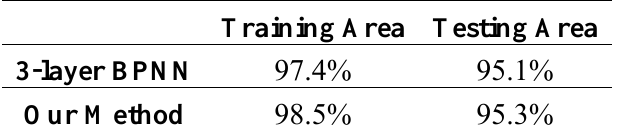
Table 5. Overall accuracies (values are given in